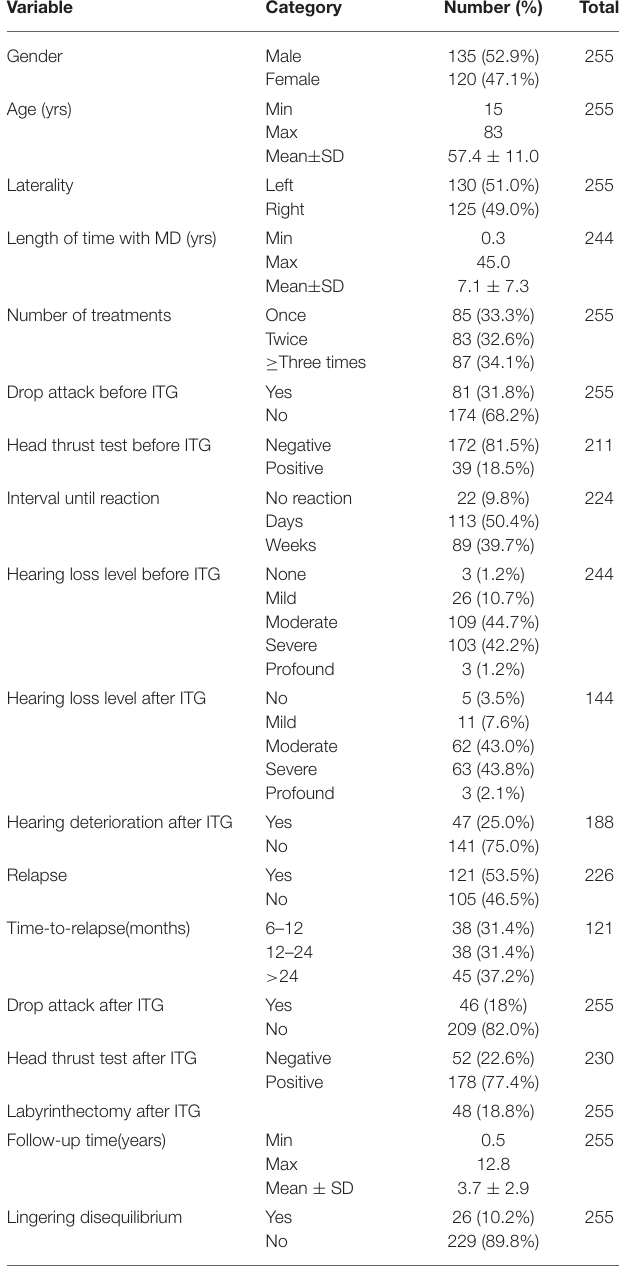
TABLE 1 | Demographics of patients treated with